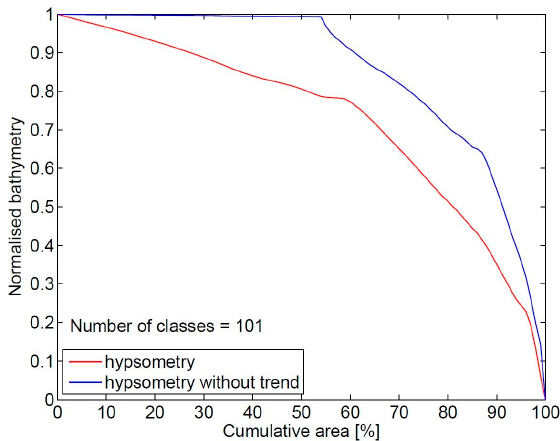
Figure 3. Hypsometric curves calculated for the inclined surface (red line) and detrended surface (blue line).